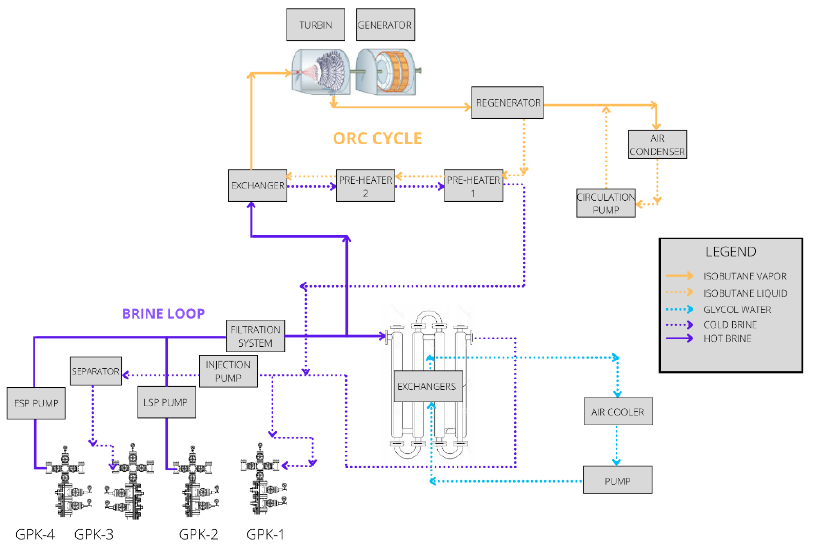
Figure 5. Construction of binary power plant in Soultz-sous-Forêts (based on